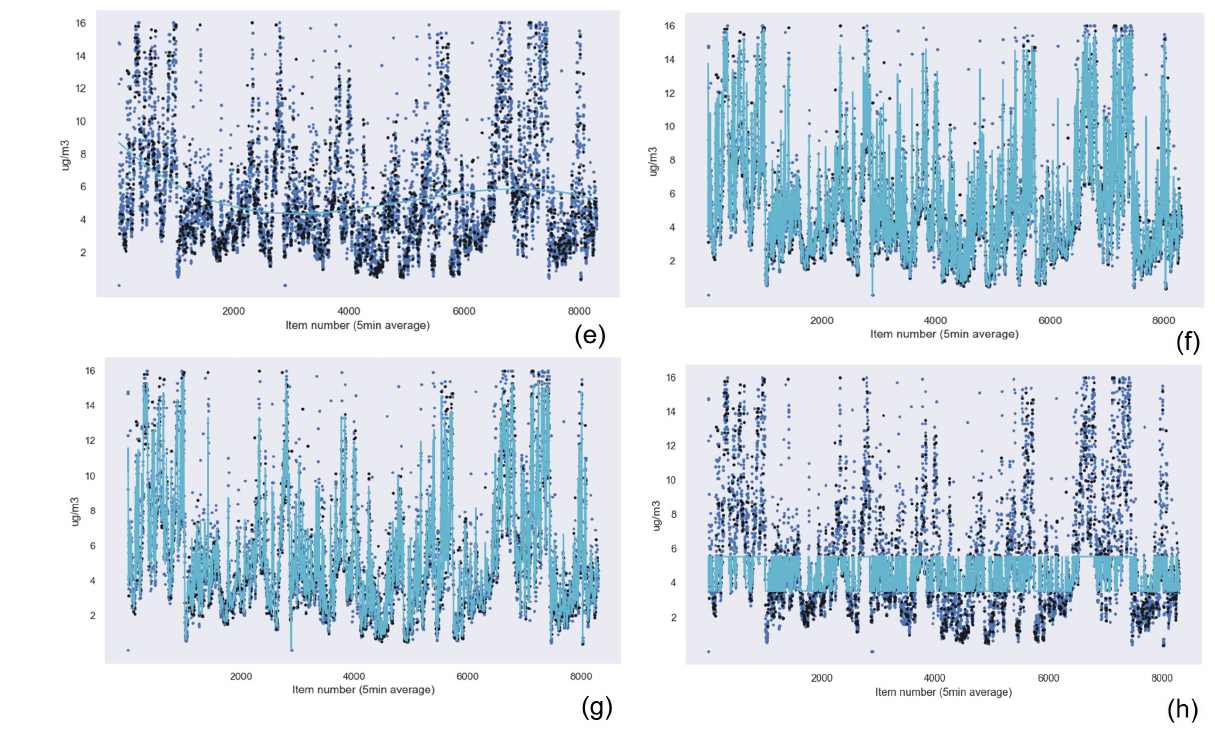
Figure A15. PM 2.5 results of the articulate matter measuring device # 2 with outliers for ( a ) Linear Re- gression ( b ) Random Forest Regression ( c ) KNN and ( d ) Support Vector Machine, and without outliers for ( e ) Linear Regression ( f ) Random Forest Regression ( g ) KNN and ( h ) Support Vector Machine.